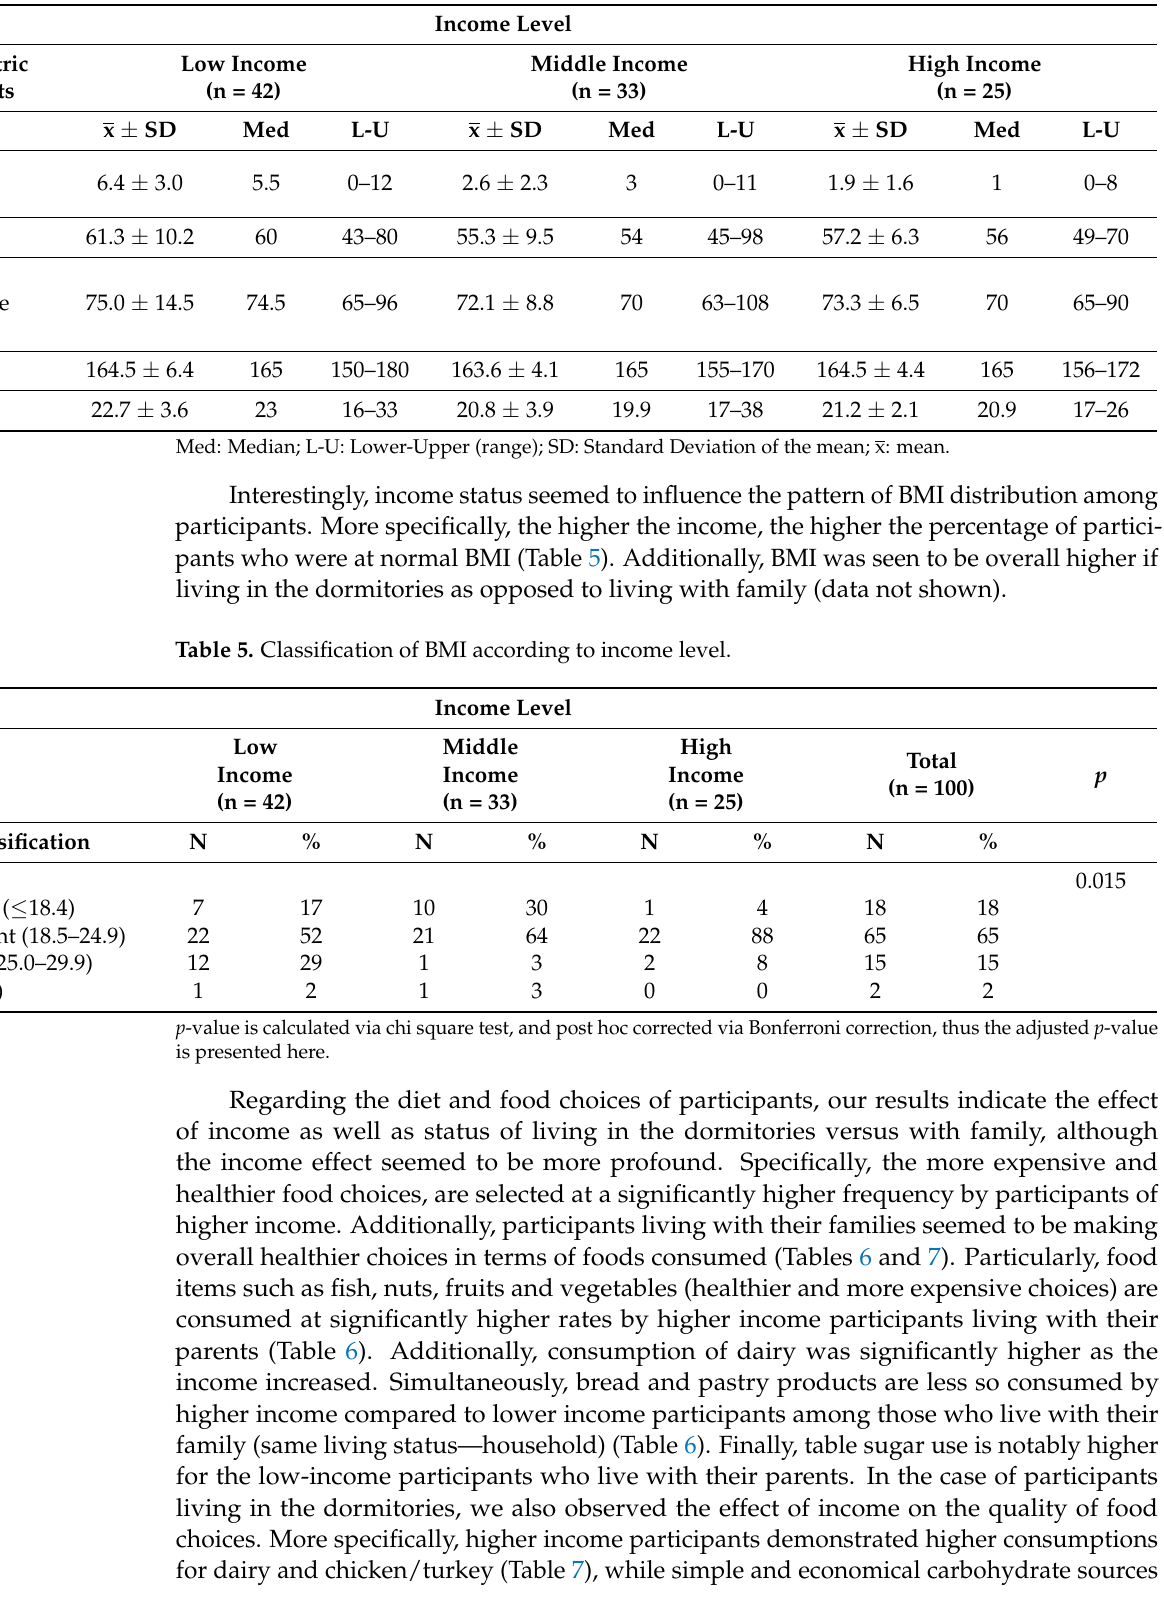
Table 4. Anthropometric measurements and diabetes risk score (FINDRISC) according to income.